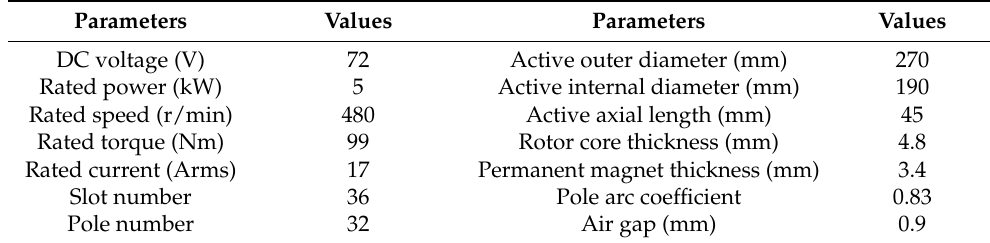
Table 1. Key parameters of the studied YASA machine.